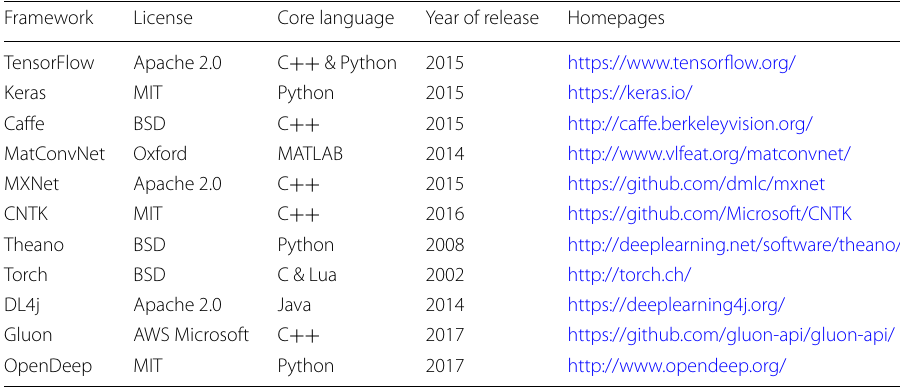
Table 4 List of the most common frameworks and libraries